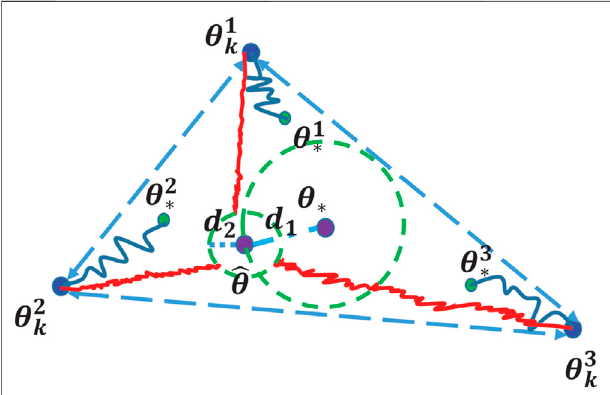
FIGURE1| Acloser look atthe optimization updates indistributeddeep learning: Blue dots represent the current states (i.e., learned model parameters)oftheagents;greendotsrepresenttheindividuallocaloptima( θ i * ), that agents converge to without suf fi cient consensus; the purple dot ( θ * ) represents the ideal optimal point for the entire agent population; another purple dot ^ θ represents a possible consensus point for the agents which is far from optimal; blue and red curves signify the convergence trajectories with different step sizes; the green dashed circles indicate the neighborhoods of θ * and ^ θ , respectively; d 2 represents the consensus bound/error and d 1 represents the optimality bound/error; ideally, both of these bounds should be